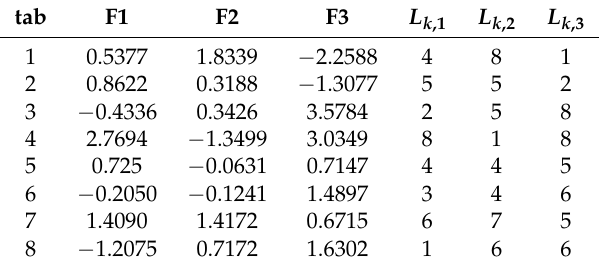
Table 1. Parallel grid coordinate system of